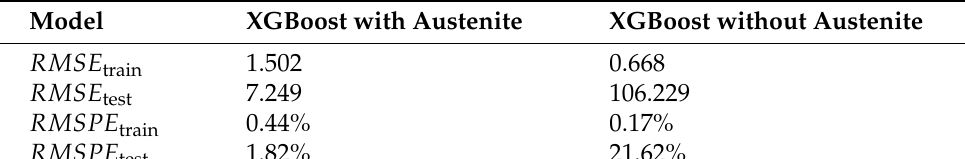
Table 7. Prediction error of the hardness computed with the XGBoost model, with and without the austenite ratio as a feature with the global